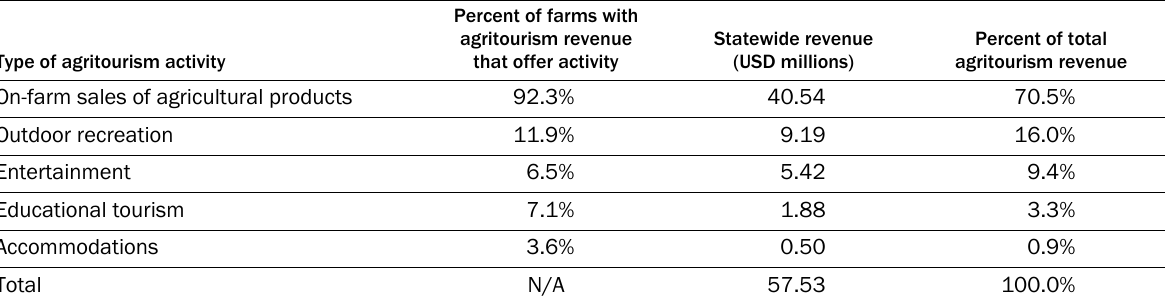
Table 6. New Jersey Agritourism Revenue, by Type of Activity (2006)